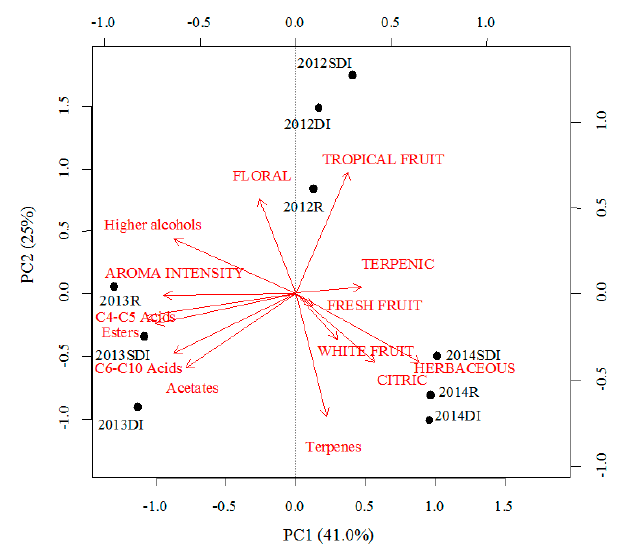
Figure 3. Principal component analysis (PCA) of Godello wines: Biplot for the first two principal components (PC) for aroma descriptors (in upper-case letters) and the different families of volatile compounds quantified (in lower-case letters). R = Rain-fed, DI = Drip irrigation, SDI = Subsurface drip irrigation.